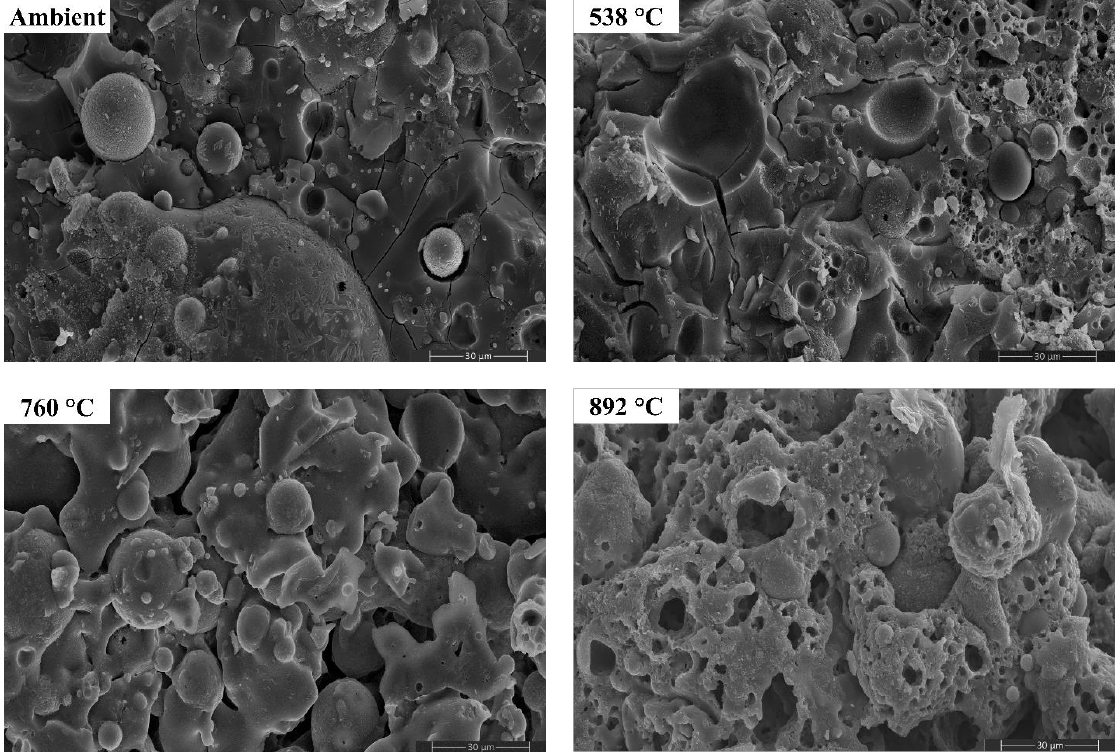
Figure 16. SEM micrographs of FS 30P-1.4 exposed to high temperatures.